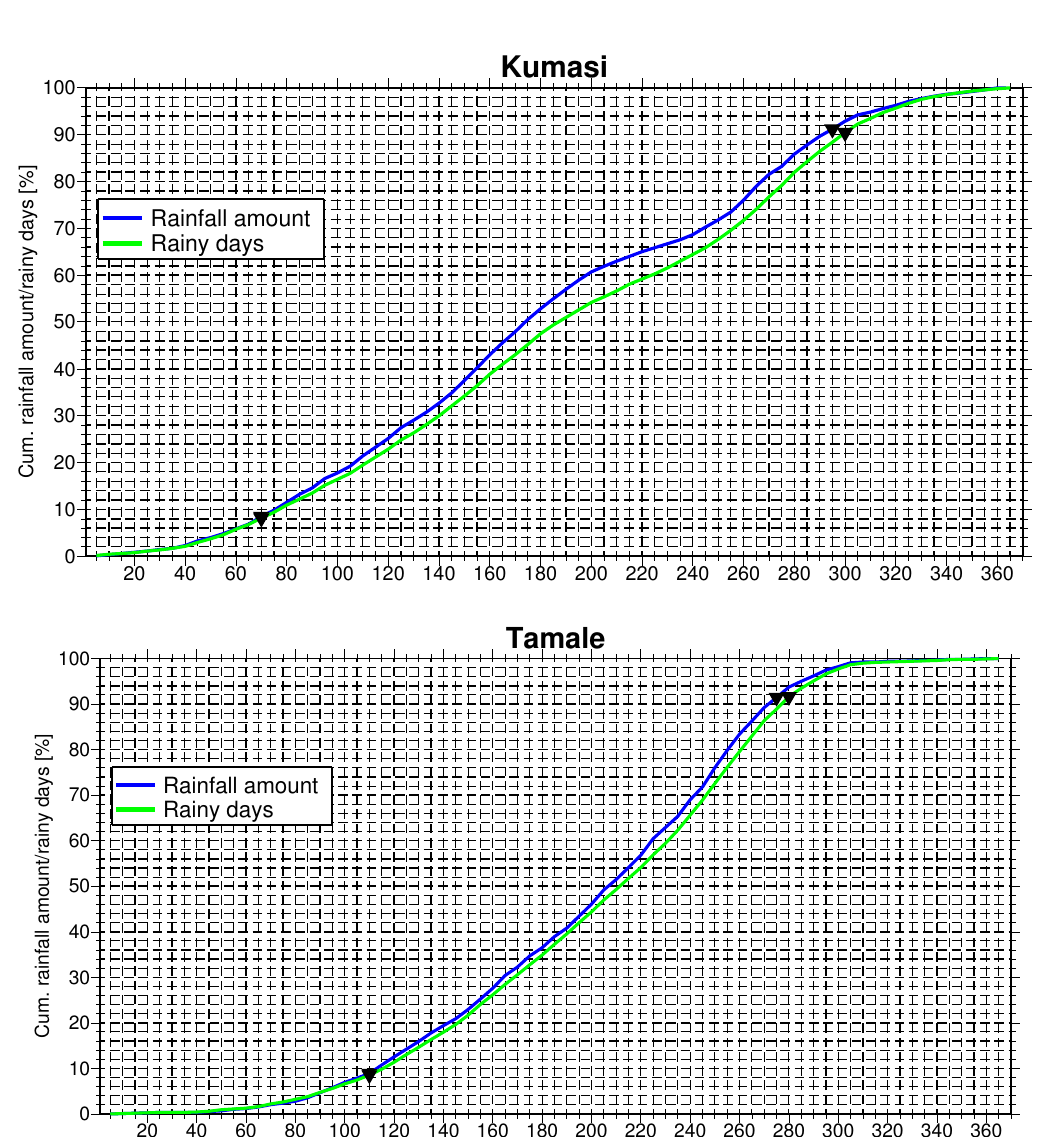
Figure 2. Example of the cumulative curve used to determine rainfall onset, cessation and length of the rainy season; bi-modal rainfall regime ( top ) and uni-modal rainfall regime ( bottom ). Rainy days method ( green ) and the rainfall amount method ( blue